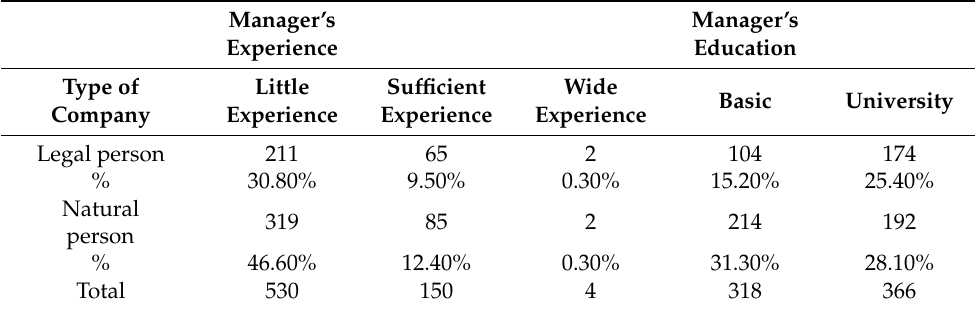
Table 2. Type of company, manager’s experience, and level of education.